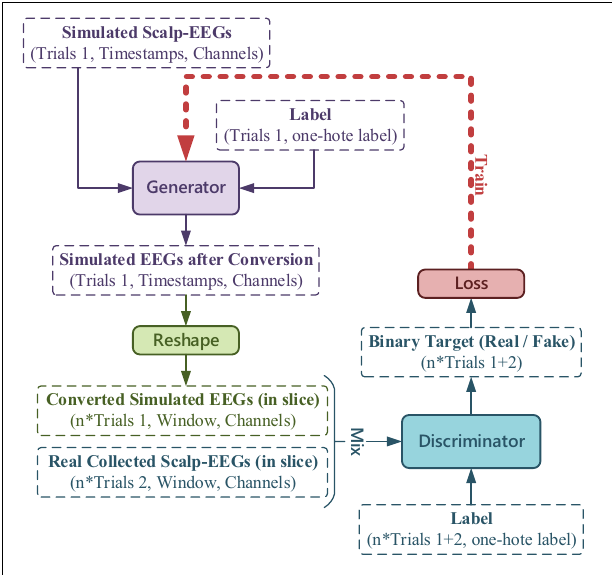
FIGURE 7 | The conditional GAN for simulated EEGs conversion, where the number of trials, timestamps, channels, and labels, and the window length is in accordance with the experimental setup (latterly stated in R ESULTS ).